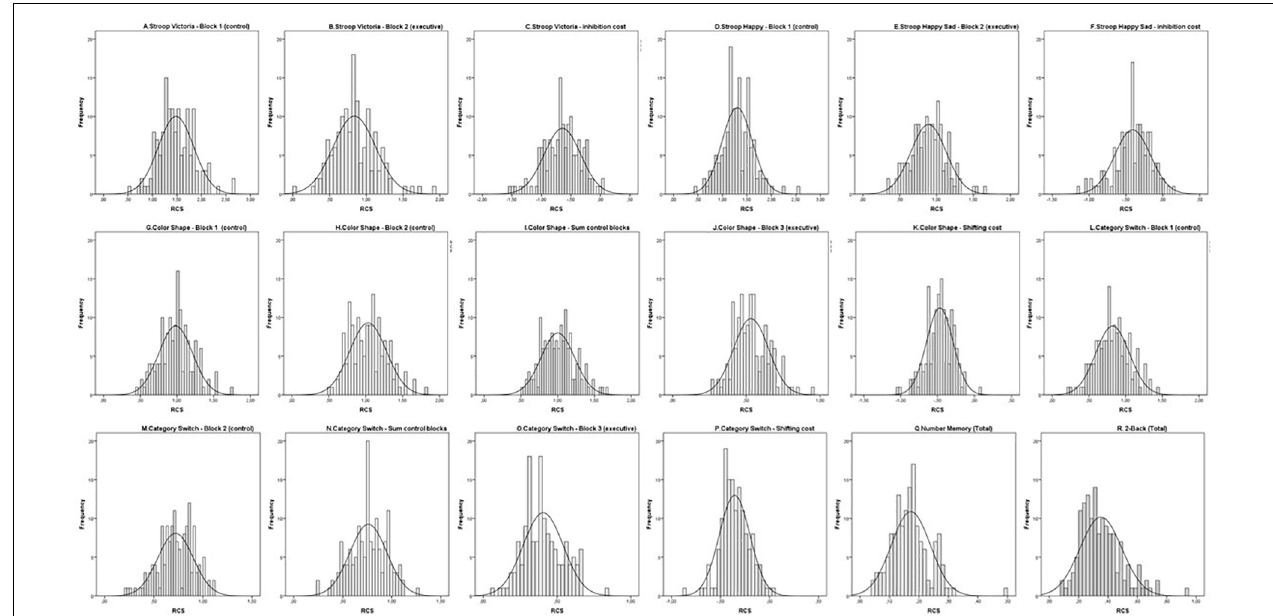
FIGURE 2 | Histograms with the frequency distribution of RCS values in the different blocks of tasks: Inhibition tasks (A–F) , shifting tasks (G–P) and updating tasks (Q,R) . The curve (line) refers to the estimated normal distribution.